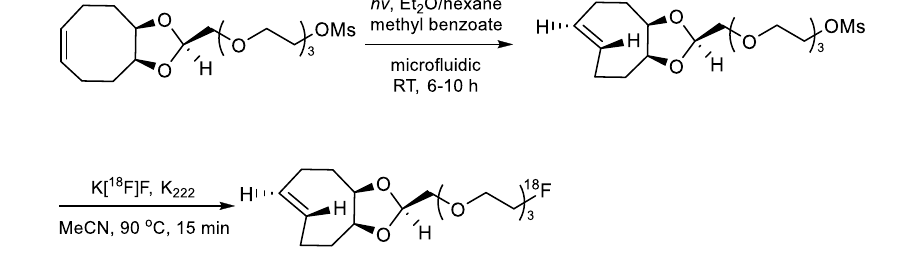
Figure 15. Radiosynthesis of 18 F-labeled TCO.